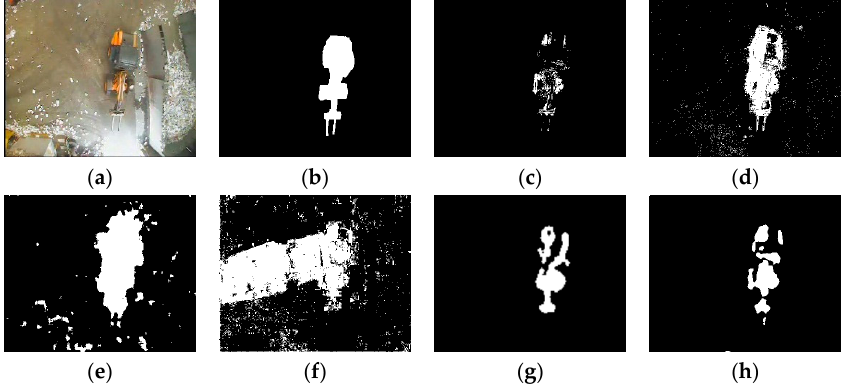
Background Adaptive Self-Organizing Modeling); ( h ) our method. Figure 9. ( a ) is the frame 485 of input images; ( b ) ground truth; ( c ) GMM (Gaussian Mixture